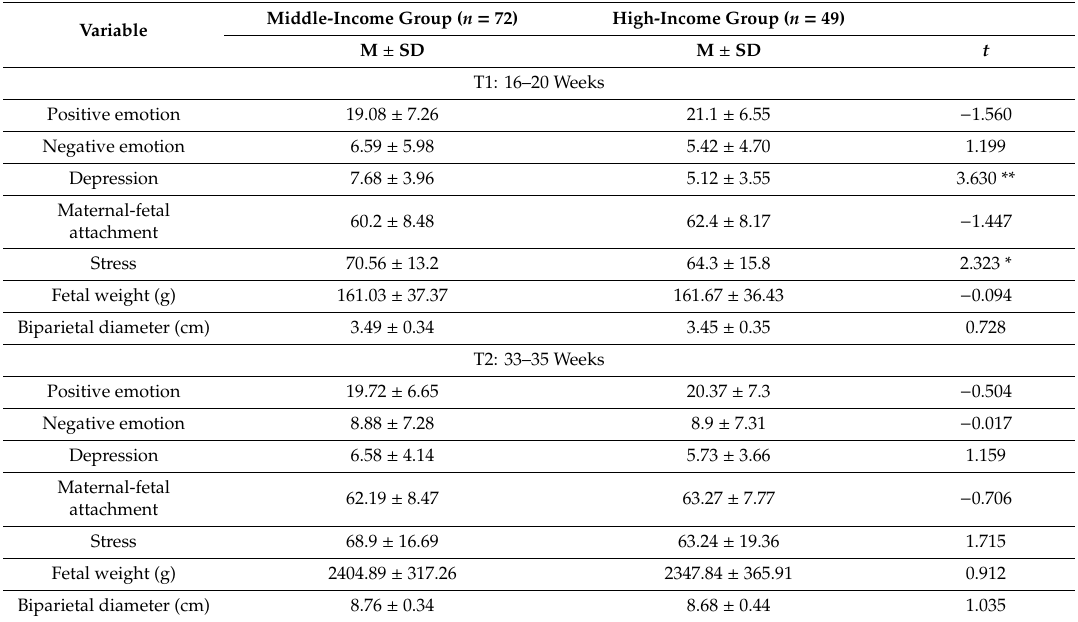
Table 2. Di ff erences between middle-income group and high-income group on maternal emotional status and fetal development ( n =